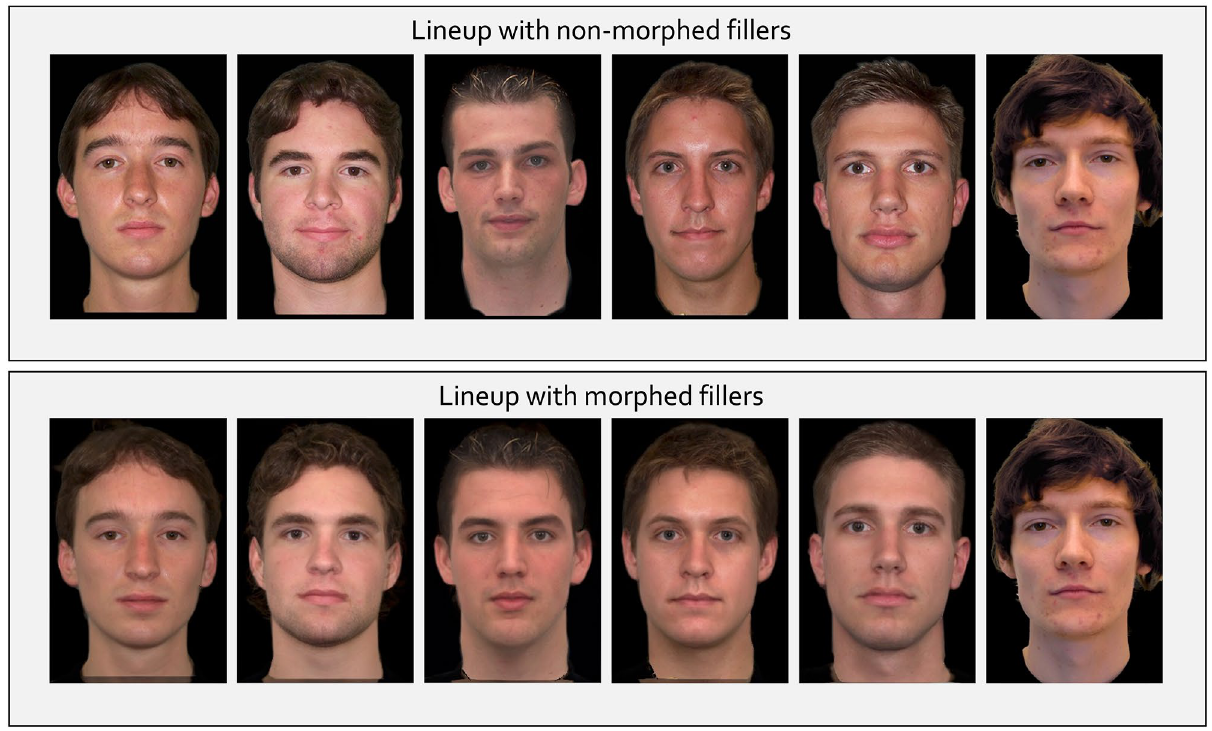
Figure 2. An illustration of a lineup with non-morphed and morphed fillers. The rightmost person represents the suspect but note that suspect and filler positions were always randomized in the experiments proper. We have written consent of the person representing the suspect to show the footage generated for the experiments. The photos of the fillers were taken from the Center for Vital Longevity Face Database 45 and the Radboud Faces Database 46 , which are freely available for academic